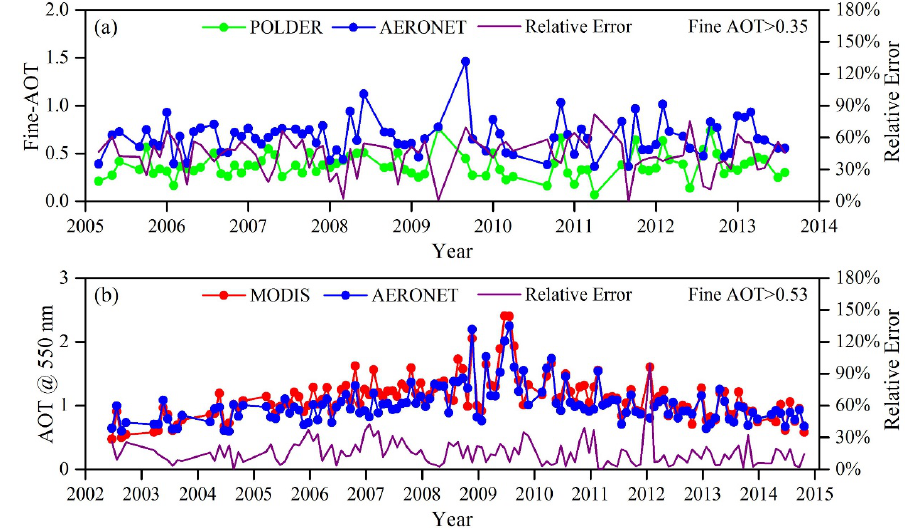
Figure 1. ( a ) Monthly averages of POLDER and AERONET fine aerosol optical thicknesses (AOTs) at 550 nm and their relative errors for daily mean fine AOTs larger than 0.35 from 2005 to 2013; ( b ) Monthly averages of MODIS and AERONET AOTs at 550 nm and their relative errors for daily mean AOTs larger than 0.53 from 2002 to 2014.